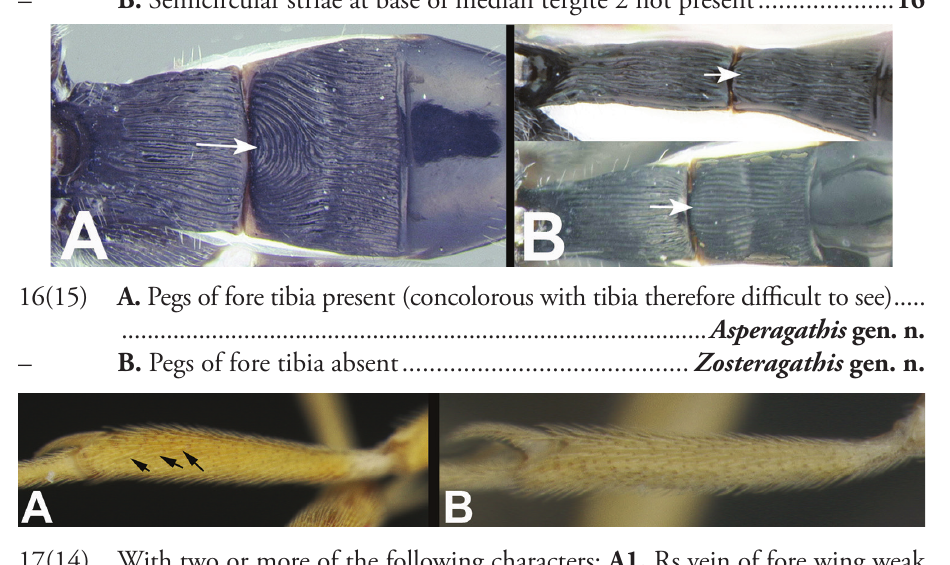
With two or more of the following characters: A1. Rs vein of fore wing weak medially and bent: A2. Sclerite separating hind coxal cavities from metasomal foramen narrow or absent. A3 . Apex of scutellum (at border with metanotum) with a distinct, often semicircular, depression. A4 . Interantennal space often with two small protrusions separated by a depression (use frontal view). A5 . Cub vein of hind wing pigmented and tubular where it is attached to subbasal cell and causing an angle in the distal margin of the cell where it is attached Note: often (70%) small and pale in coloration............ Therophilus Wesmael – With none or at most one of the above character states. Rather the follow- ing character states apply: B1. Rs vein of fore wing evenly sclerotized and straight. B2. Sclerite separating hind coxal cavities from metasomal foramen relatively wide. B3 . Apex of scutellum (at border with metanotum) smooth or sculptured but lacking deep depression(s). B4 . Interantennal space with- out two small protrusions separated by a depression (use frontal view), rather smooth, or with a median keel that may or may not be pronounced. B5 . Cub vein of hind wing absent, OR not attached to basal cell, OR not pigmented, and subbasal cell not angled at point of intersection. Note: often (70%)